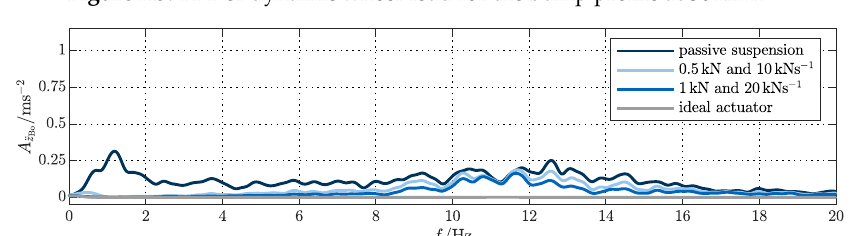
Figure A3. FFT of dynamic wheel-load for the bump profile at 36kmh − 1 .